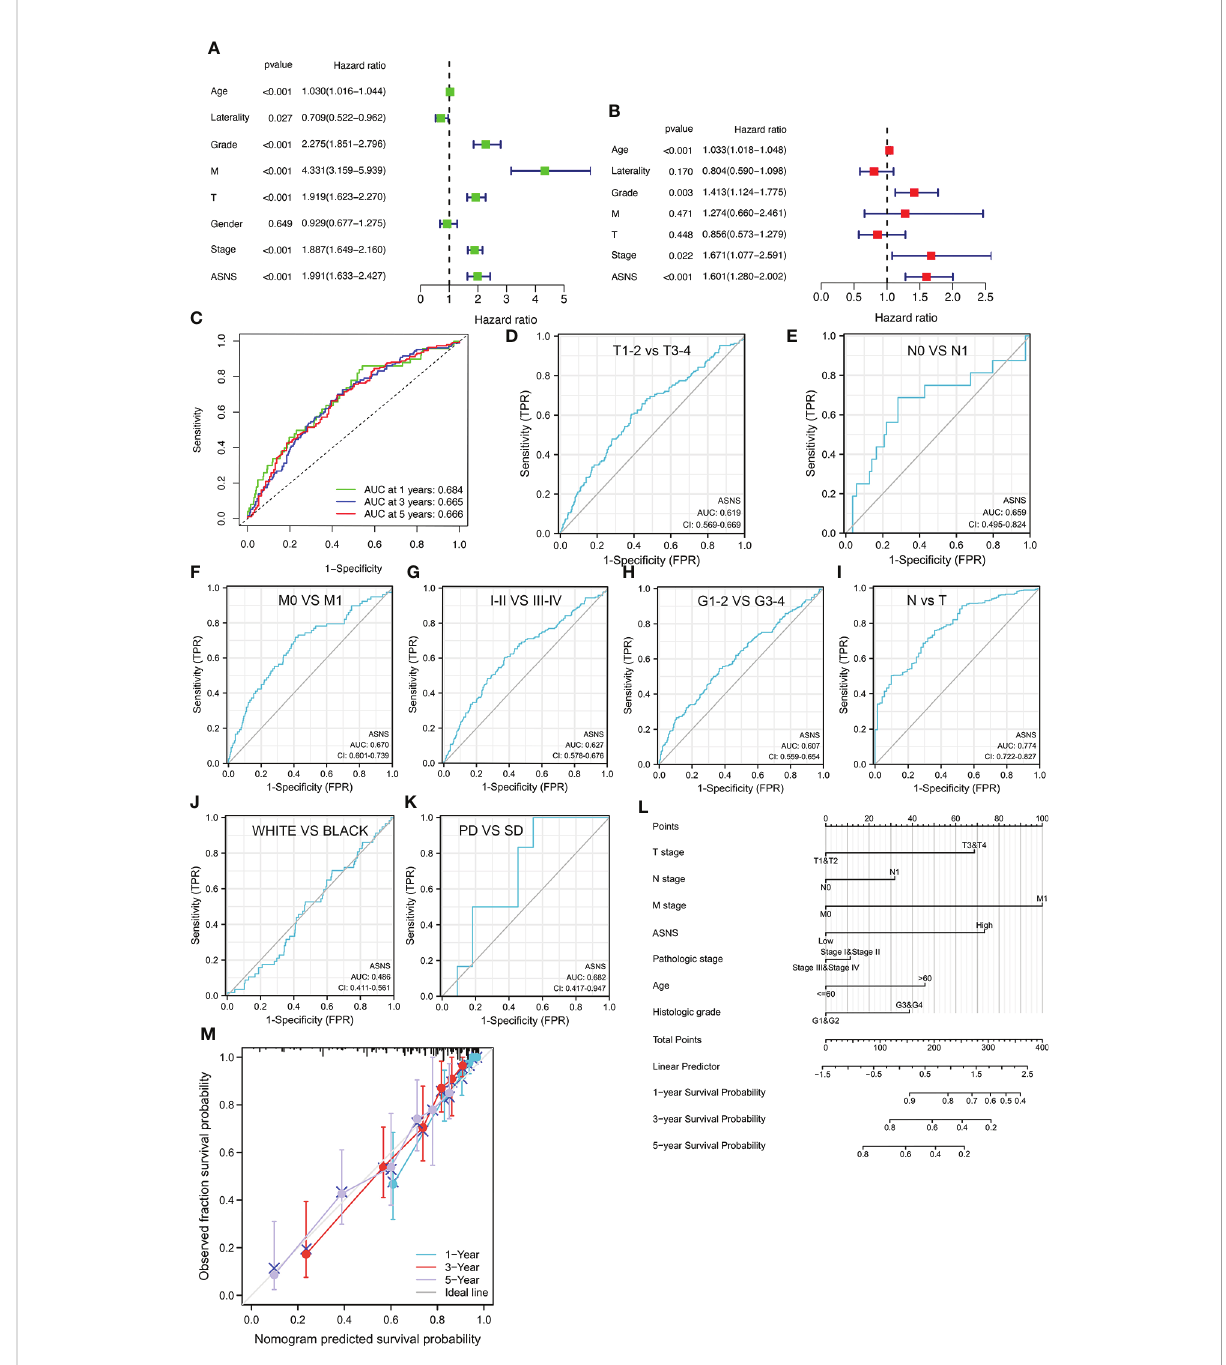
FIGURE 3 Identi fi cation of ASNS as an independent prognostic factor for ccRCC. (A, B) Univariate and multivariate independent prognostic analysis of ASNS . (C) Receiver operating characteristic (ROC) curve predicting the correlation between ASNS expression and OS. (D – K) ROC curve predicting the correlation between ASNS expression and clinicopathological features [T1 – 2 vs . T3 – 4, N0 vs . N1, M0 vs . M1, pathological stage I – II vs . III – IV, neoplasm histological grade 1 – 2 vs . 3 – 4, normal vs . tumor, race (white vs . black), and primary therapeutic outcome, i.e., partial disease vs . stable disease]. (L, M) Nomogram and calibration plots,